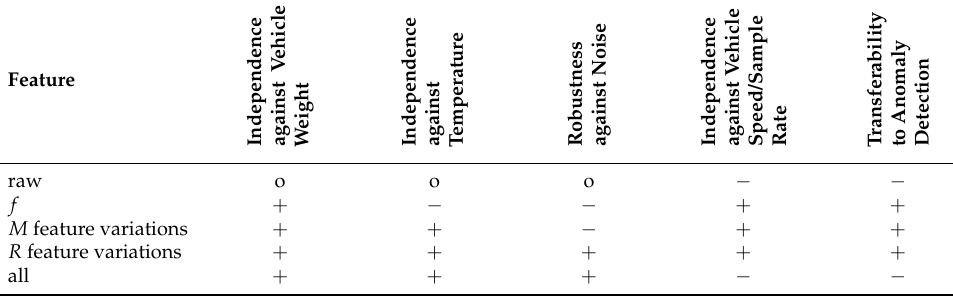
Table 7. Summary of the classification results with respect to the suitability of the features for anomaly detection on real